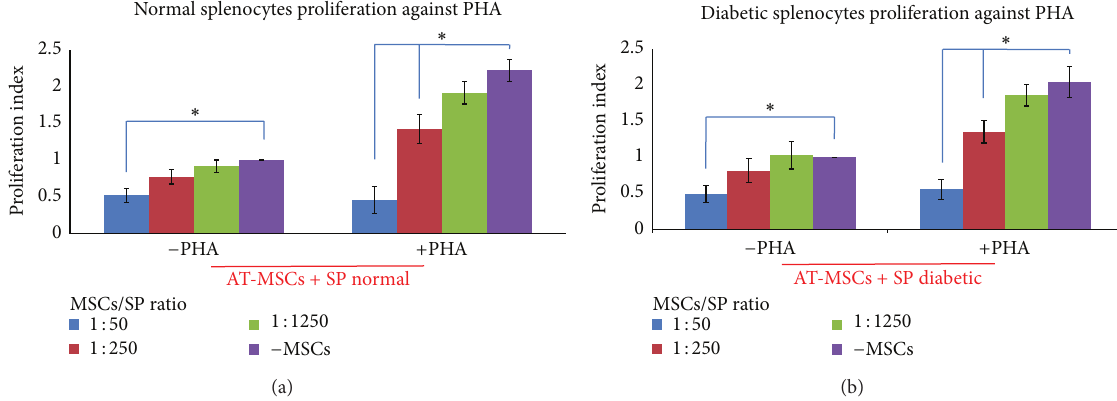
Figure 1: Proliferation index of splenocytes from normal (a) and diabetic (b) mice cocultured with AT-MSCs in presence of PHA as nonspecific stimulator. The resting splenocytes showed a sharp proliferation response in the presence of PHA. AT-MSCs caused cell death in some resting splenocytes in the absence of mitogen (proliferation index < 1.0). AT-MSCs could suppress normal and diabetic splenocytes proliferation in response to PHA in a dose-dependent manner, where greater concentration of AT-MSCs induced cell death in some splenocytes (proliferation index < 1.0). Each bar represents the average of five independent experiments. ∗ indicates significant difference between groups ( 𝑃 < 0.05 ). PHA: phytohemagglutinin; SP: splenocytes.